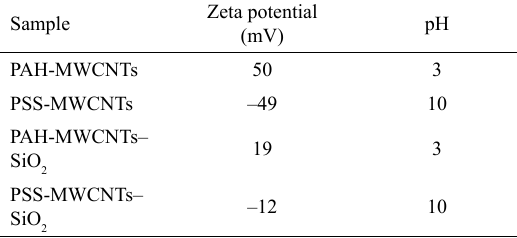
Table 1. Zeta potential value (z) of MWCNTs coated with polyelectrolyte PAH, PSS and silica measured at different pH values.